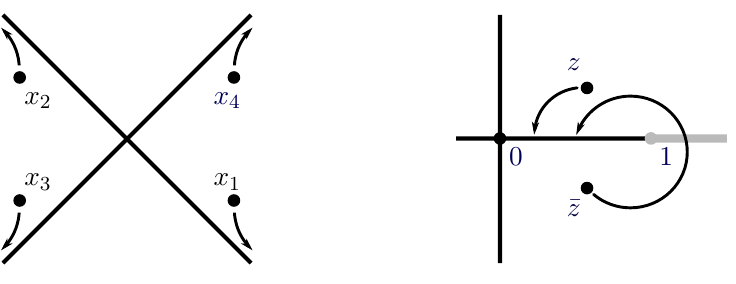
Figure 1 . Four-point kinematics in the CFT Regge regime. Panel (a) illustrates the kinematics, in which time runs vertically, and panel (b) illustrates the analytic continuation G ( z, z (cid:9) ) : counter- clockwise about the branch point. In the Euclidean regime z ∗ = z but both z and z are real and independent in Lorentzian